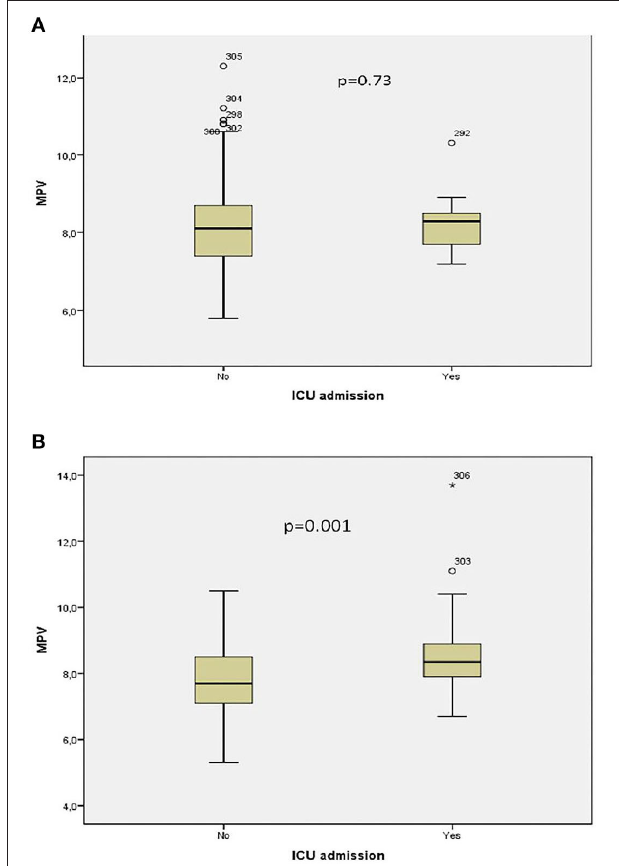
FIGURE 3 | (A) Association between intensive care unit transfer and mean platelet volume levels when D-dimer < 1.0 mg/L. (B) Association